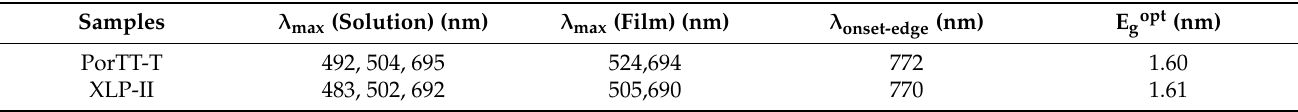
Table 2. The data of optical absorption and the optical band gap of PorTT-T and XLP-II. Samples